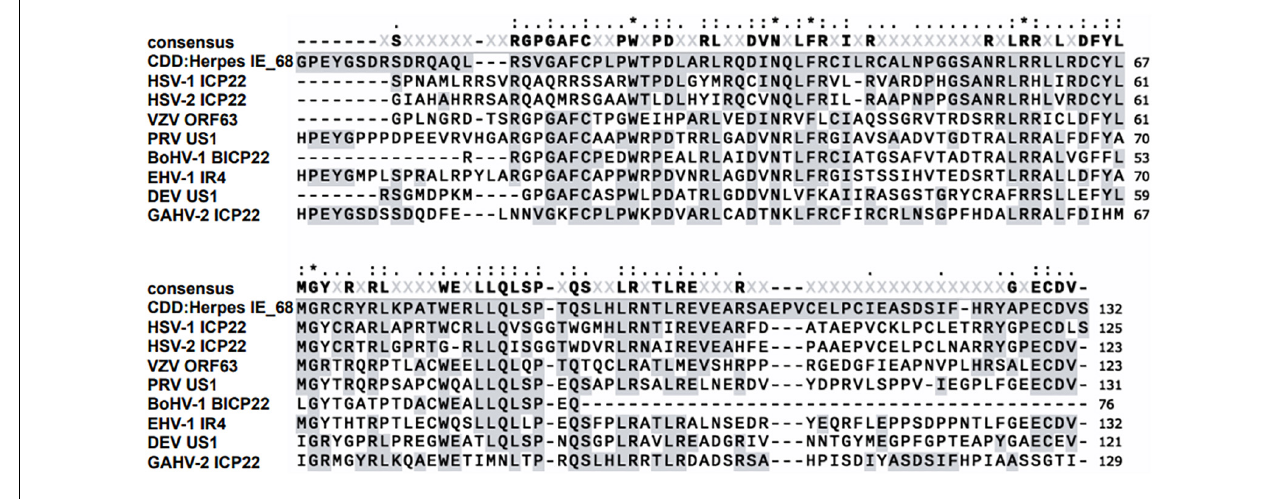
FIGURE 1 | Sequence alignment of the conserved IE-68 domain of representative human herpesviruses. TABLE 1 | Viral and cellular factors that interact with ICP22/ORF63 proteins during the human herpesvirus life cycle. Process of in the ICP22/ORF63 Interaction Functional herpesvirus life protein partners cycle